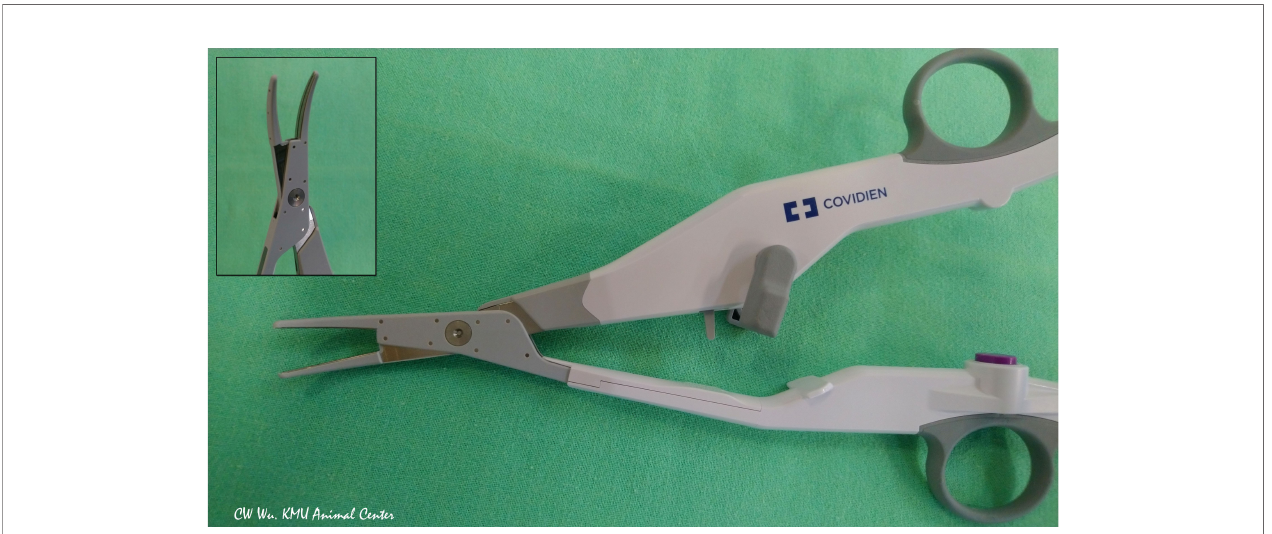
FIGURE 3 | The LigaSure Exact Dissector (LED) (Medtronic, Mineapolis, MN, USA) is an advanced bipolar energy based device commonly used for open thyroid surgery. The fi nely curved symmetrical jaws have an anti-adherent